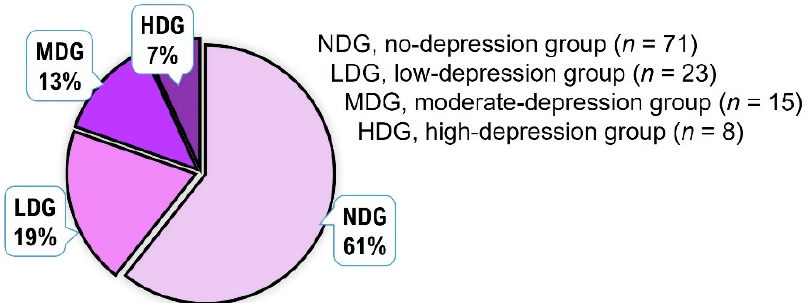
Figure 3. Frequency analysis of depression levels for all adolescents.